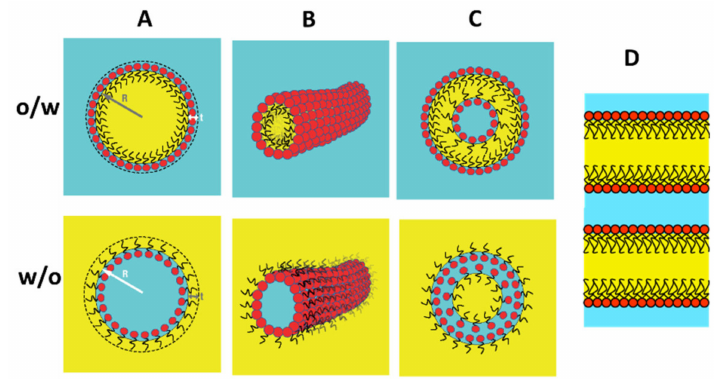
Figure 1. Cartoon of self-assembled surfactant structures in microemulsions. Upper row oil-in-water, lower row water-in-oil. ( A ) Spherical micelles; ( B ) cylindrical micelles; ( C ) vesicles; ( D ) bicontinuous planar